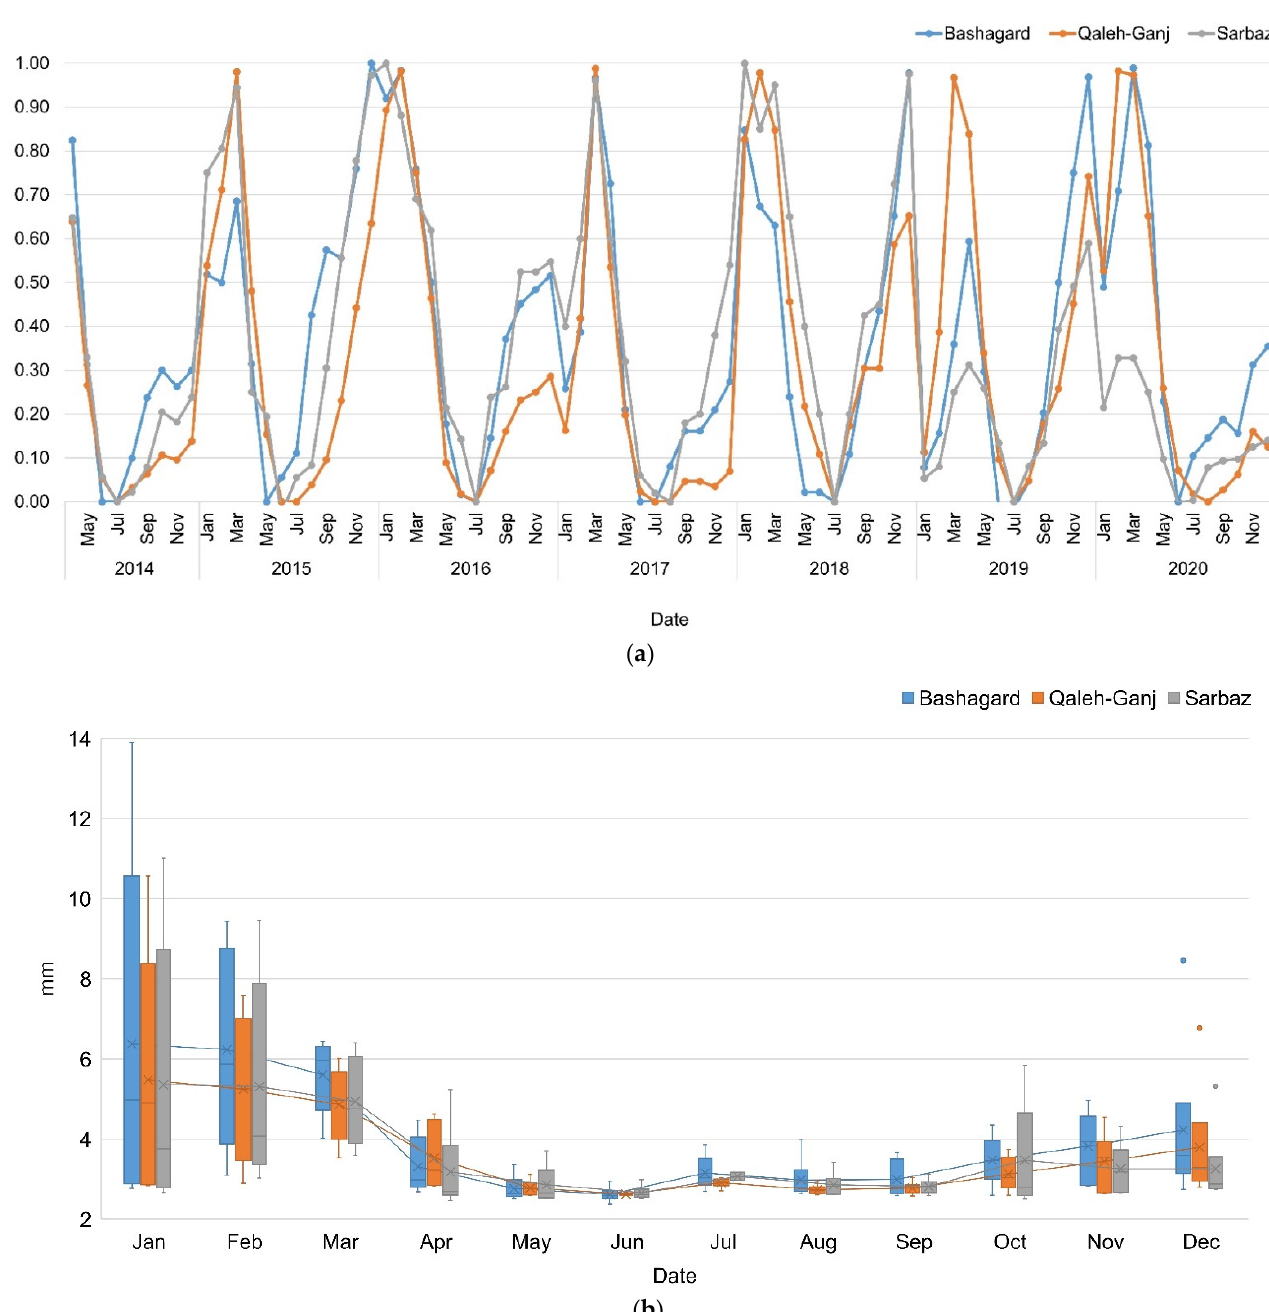
Figure 9. ( a ) VCI time series; ( b ) Box plot of VCI time series of Qaleh-Ganj, Sarbaz and Bashagard counties, Iran, 2014–2020.